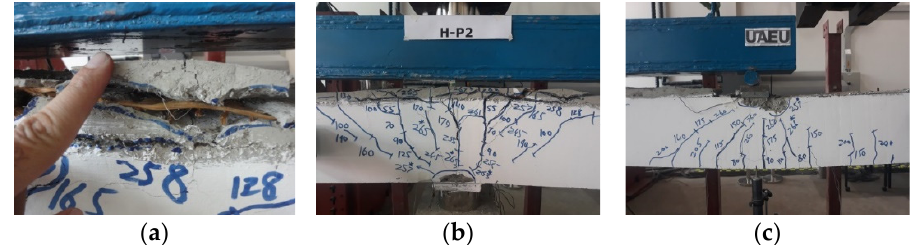
Figure 9. Typical failure modes of the specimens with hogging strengthening (H-P2): ( a ) Close-up view of fabric–matrix interface debonding; ( b ) Interfacial debonding at fabric–matrix interface and concrete crushing at hogging; ( c ) Concrete crushing at sagging.